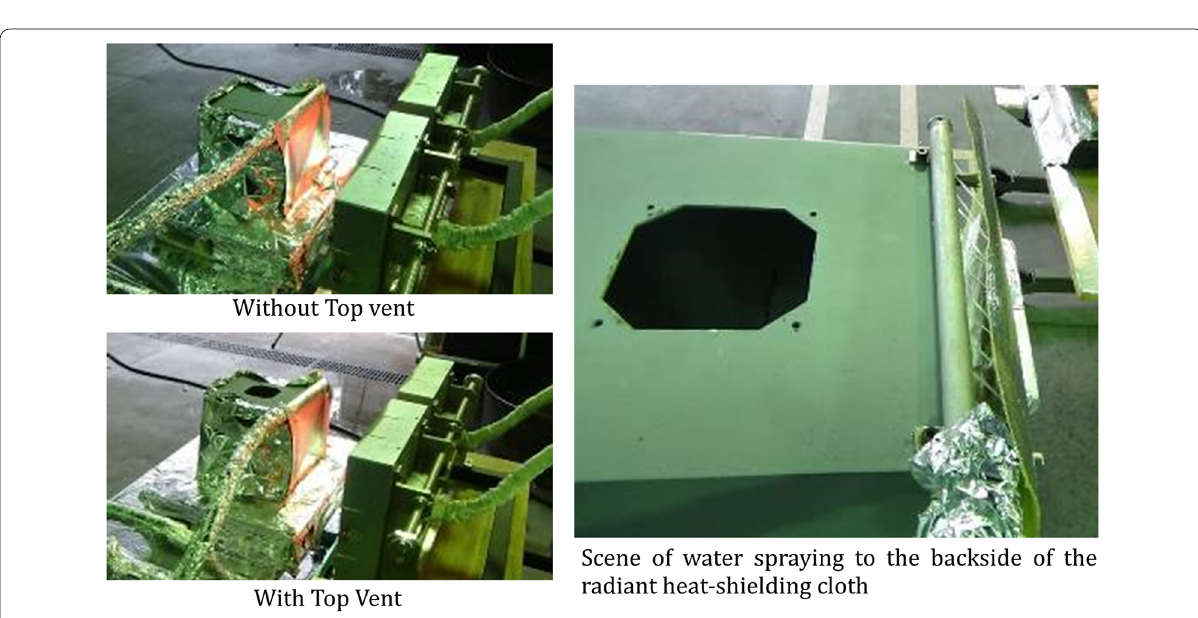
Fig. 9 Setting of the radiation heat transfer